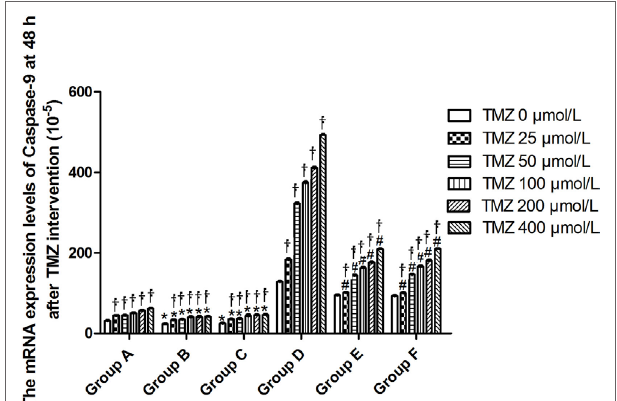
FigUre 7 | The mRNA expression levels of Caspase-9 at 48 h after temozolomide (TMZ) intervention (10 − 5 ). * P < 0.05, compared with Group A in the same concentration; † P < 0.05 compared with the concentration of 0 µmol/L; # P < 0.05 compared with Group D in the same concentration. Group A: TJ905 cells transfected with Livin-shRNA, Group B: TJ905 cells transfected with negative-shRNA, Group C: the monolayer culture of TJ905 glioma cells, Group D: glioma stem cells transfected with Livin-shRNA, Group E: glioma stem cells transfected with negative-shRNA, and Group F: the monolayer culture of TJ905 glioma stem